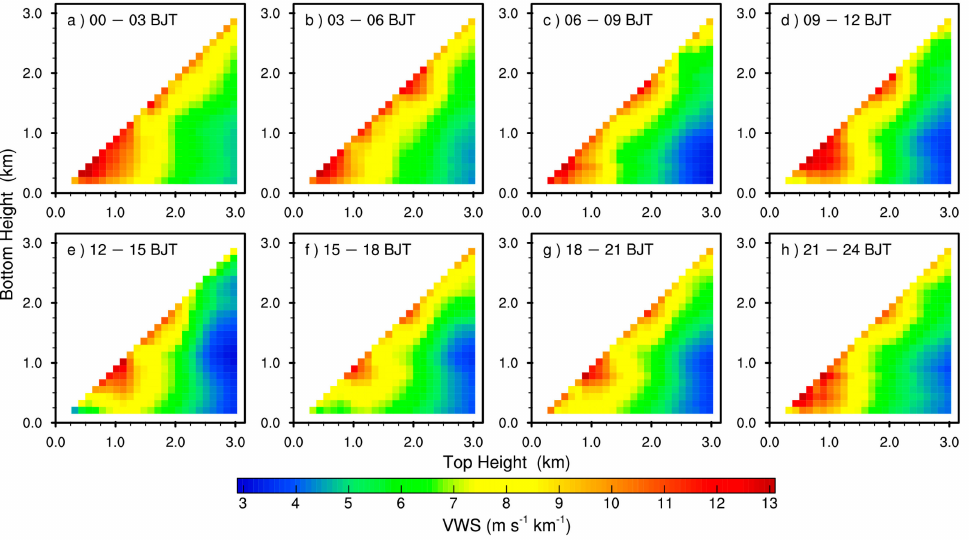
Figure 7. Same as Figure 6 but under clean